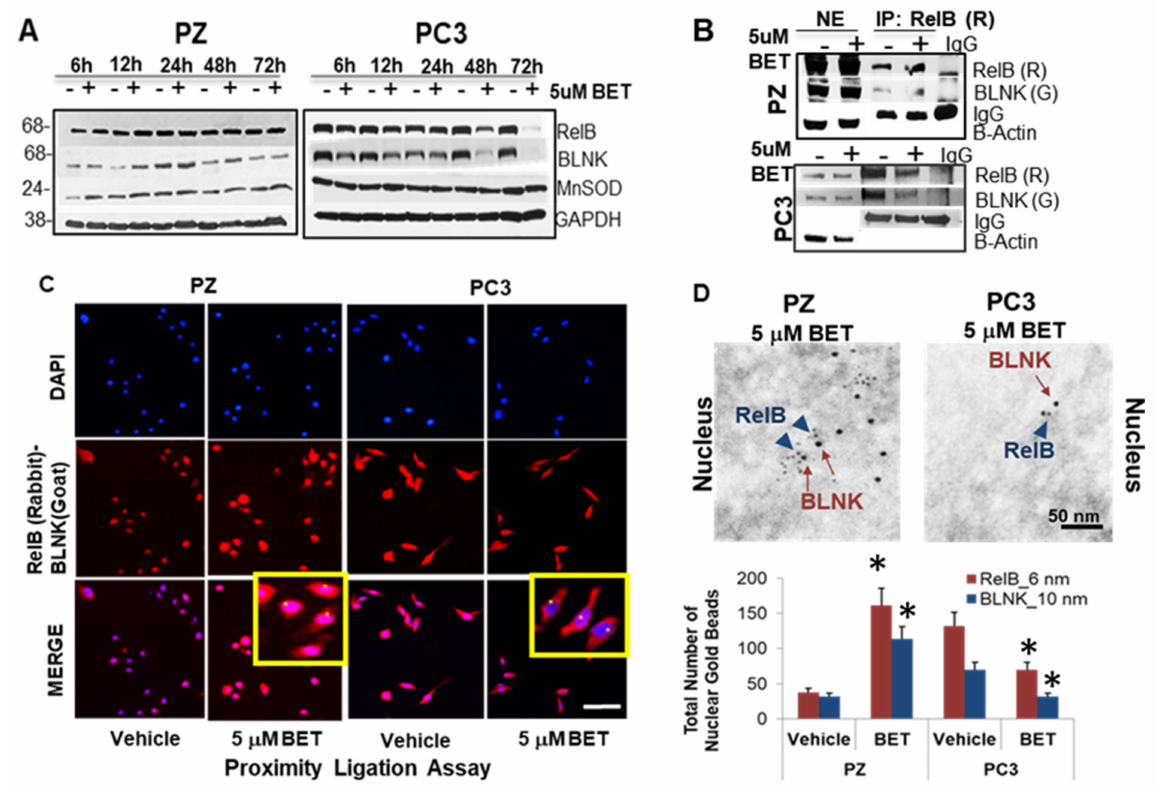
Figure 6. RelB and BLNK exert their roles reversely in non-PCa cells vs. PCa cells with BET treatment. Cells were treated with BET for 24 h and then harvested for analysis. ( A ) Western blots of BLNK, RelB, and MnSOD upon BET treatment. ( B ) IP with RelB antibody in whole cells nuclear fraction (NE) after treatment with BET. R = Anti-rabbit antibody. G = Anti-goat antibody. ( C ) Proximity Ligation assay. Red = Binding of RelB and BLNK. Blue = Nucleus. Inserts indicate the binding of RelB and BLNK in the nuclei of PZ cells (yellow) but not in the nuclei of PC3 cells (yellow). Bar = 50 µ m. ( D ) Representation of double immunogold electron microscopy of cells and quantification of gold bead number in nuclei. PZ cells or PC3 cells were labeled with anti-rabbit RelB antibody (6 nm gold beads, arrow heads) and anti-goat BLNK antibody (10 nm gold beads, arrow). The gold beads were localized primarily in the nuclei of PZ cells after BET treatment but less in the nuclei of PC3 cells. * p -value ≤ 0.05 when compared with vehicle. Twenty nuclei were counted per